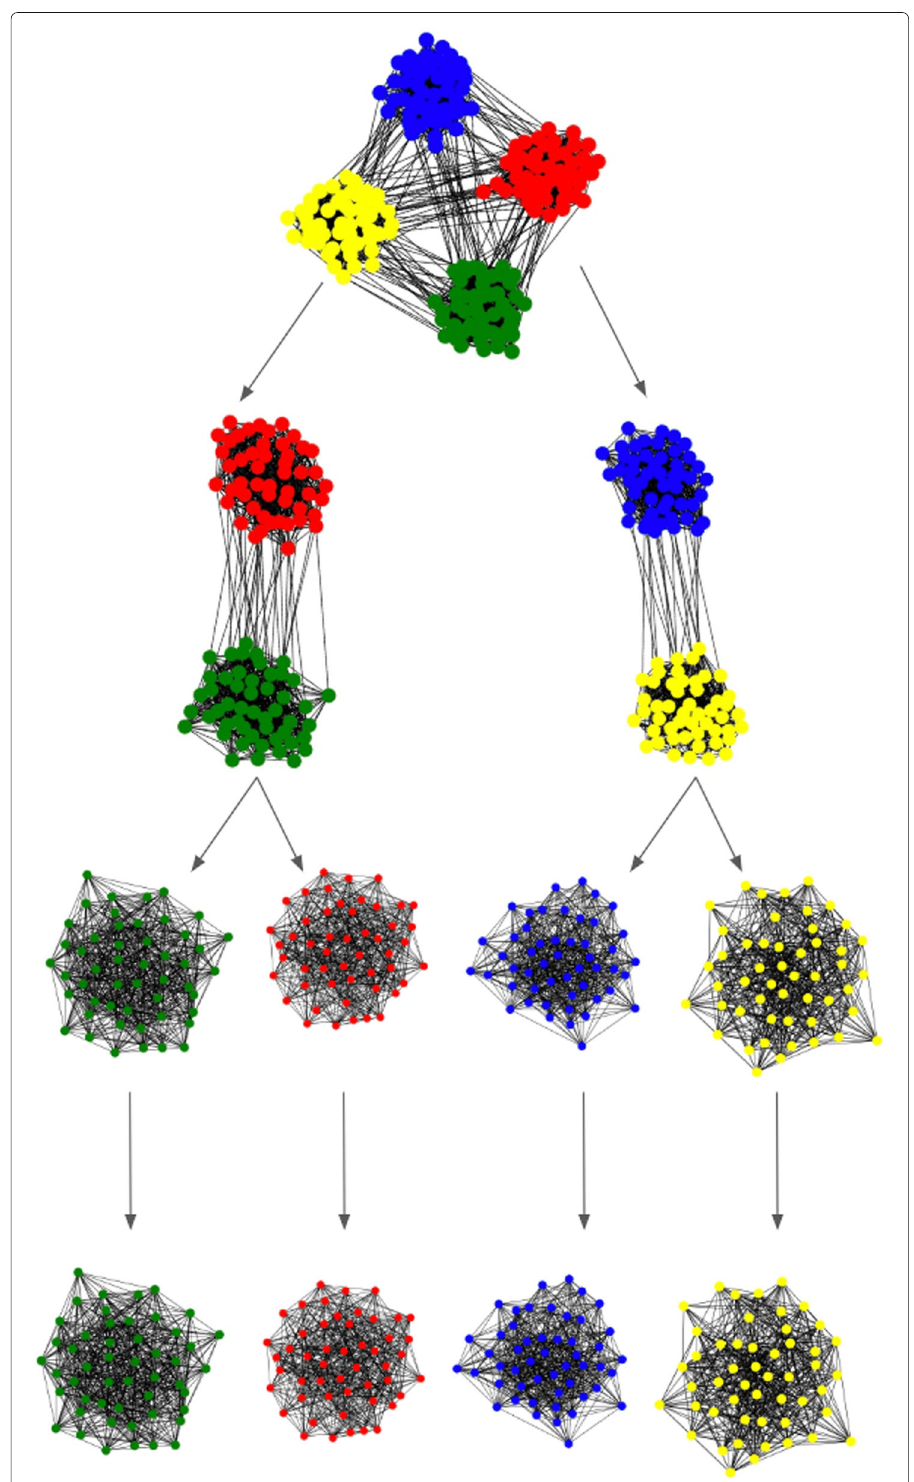
Fig. 2 Schematic representation of the iterative procedure used by the algorithm to detect multiple communities. In this example, the top graph is a sample network with 4 communities. In the first iteration, the algorithm splits the network perfectly into two equal communities. In the next iteration, each network is split perfectly again. The algorithm terminates because the next iterations do not lead to the discovery of other